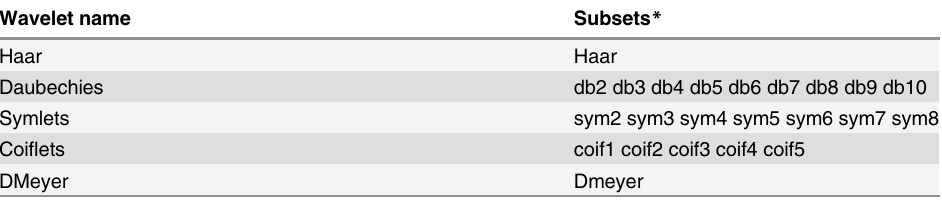
Table 1. Wavelet families and